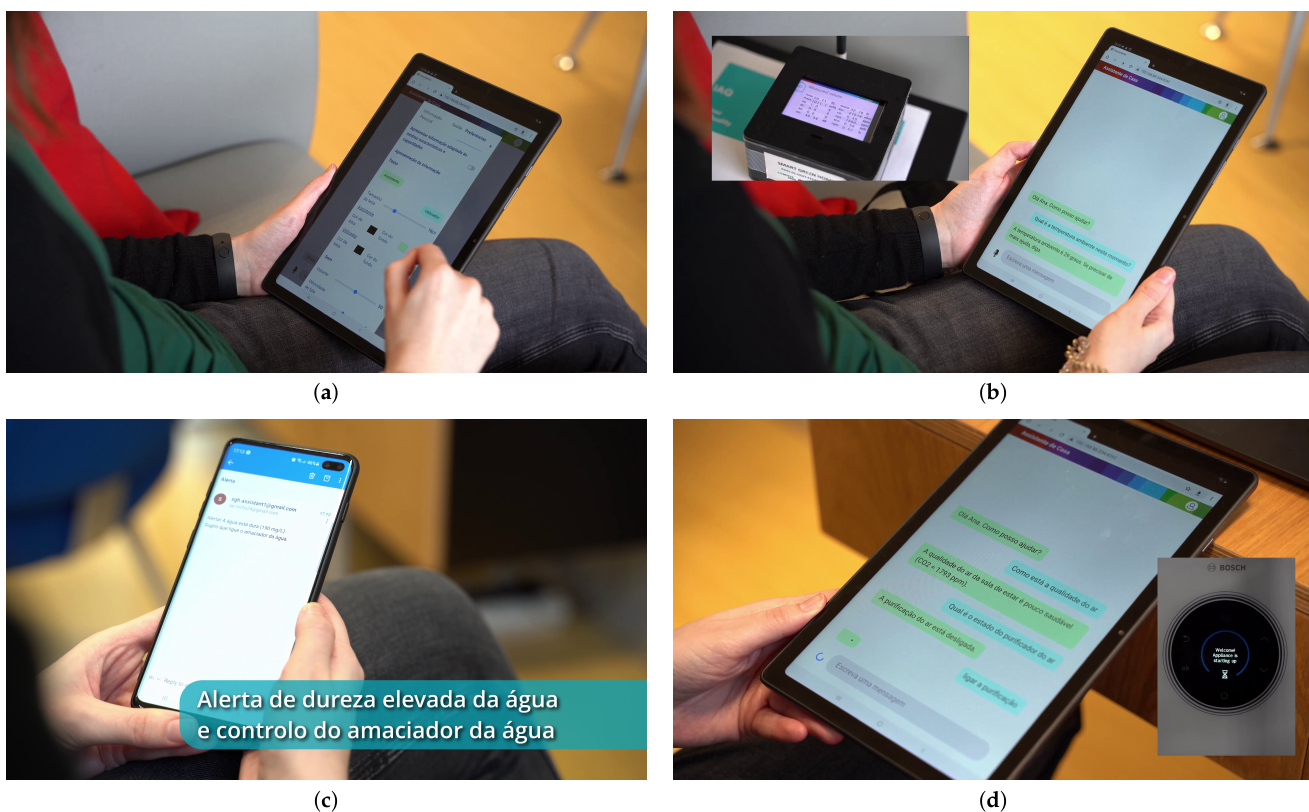
Figure 3. Screenshots of the video with the assistant’s demonstration (in European Portuguese), corresponding to the following tasks: ( a ) choosing output preferences; ( b ) consulting the ambient temperature (measured by the sensor box); ( c ) receiving an alert regarding water high hardness, which is later followed by turning on the water softener; and ( d ) turning on the air purifier, after being informed that the air quality is